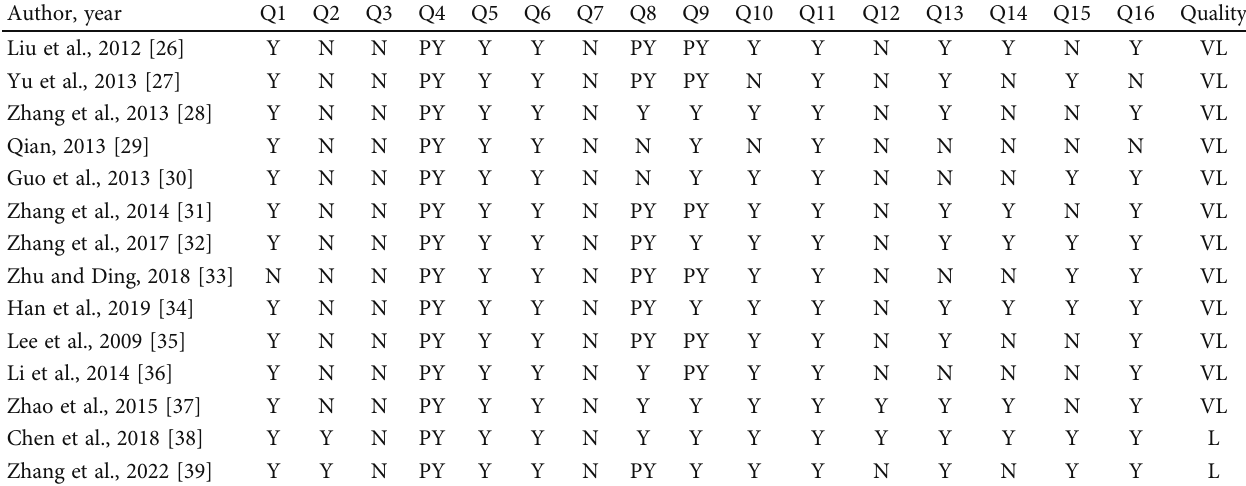
Table 3: Result of the AMSTAR-2